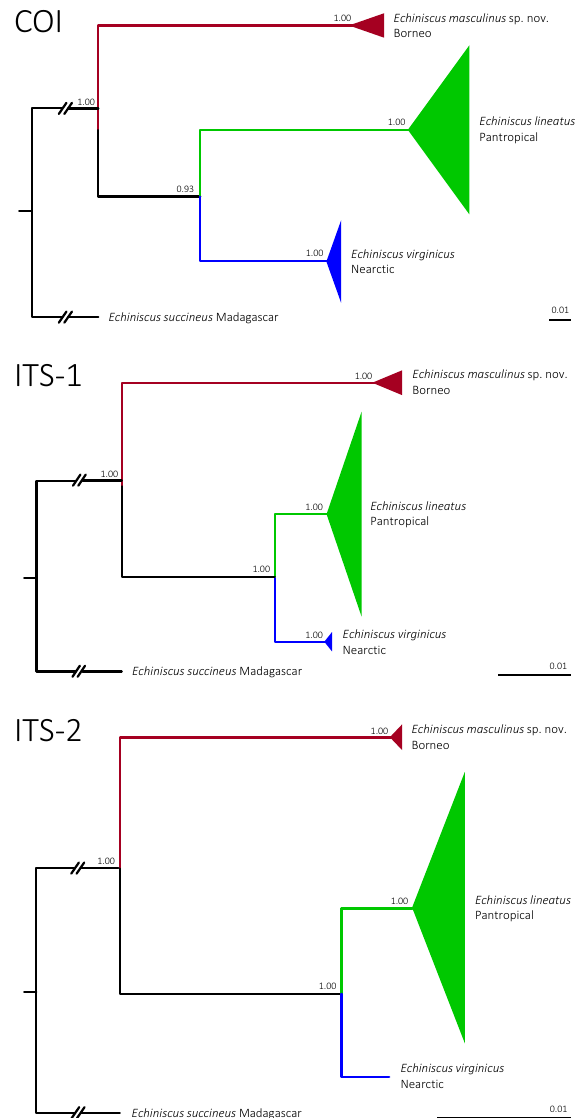
Figure 4. Bayesian phylogenetic trees showing the relationships between members of the E. virginicus complex; E. succineus was used as an outgroup, and branches within species-specific clades were collapsed. Bayesian posterior probability values are given above tree branches. Phylogenetic analyses were run on the subsequent DNA markers to assure that the tree topology was congruent: COI, ITS-1, and